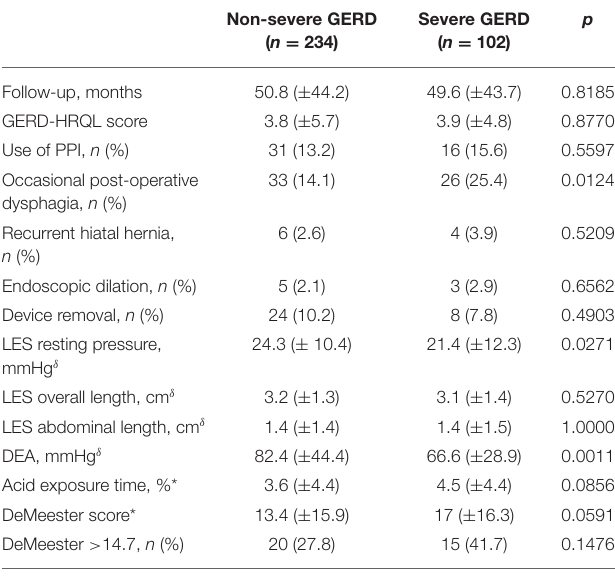
TABLE 5 | Post-operative outcomes in patients undergoing MSA for severe or non-severe